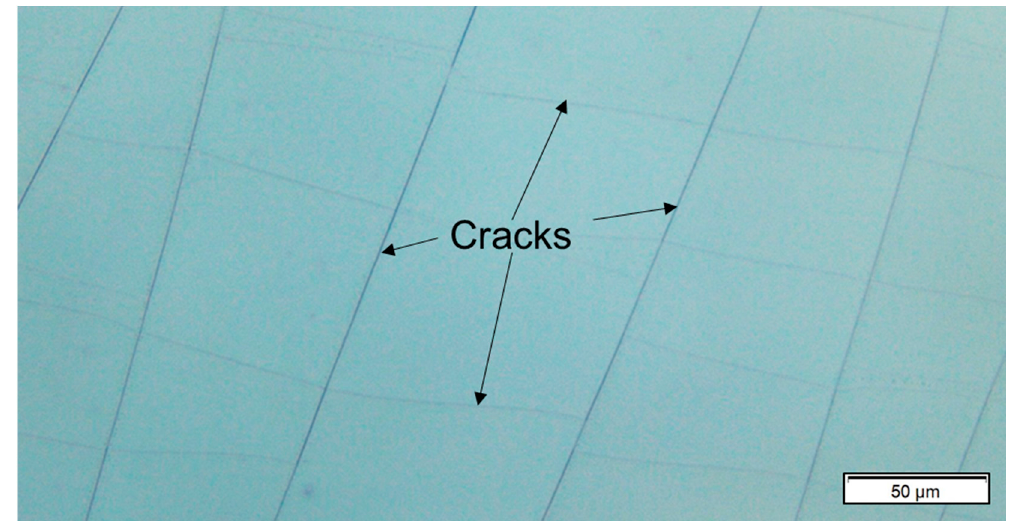
Figure 6. Image of cracked Ecoflex surface 10× magnified after 1.5 s plasma treatment.